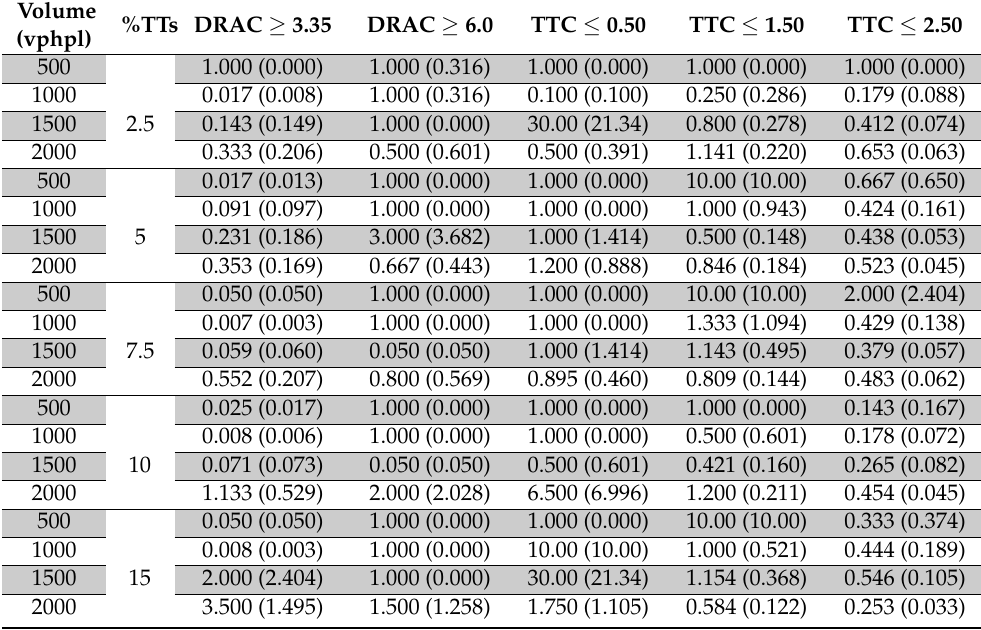
Table 9. Conflict ratio between TT speed of 70 km/h before and TT speed of 90 km/h after for PC speed limit of 100 km/h.